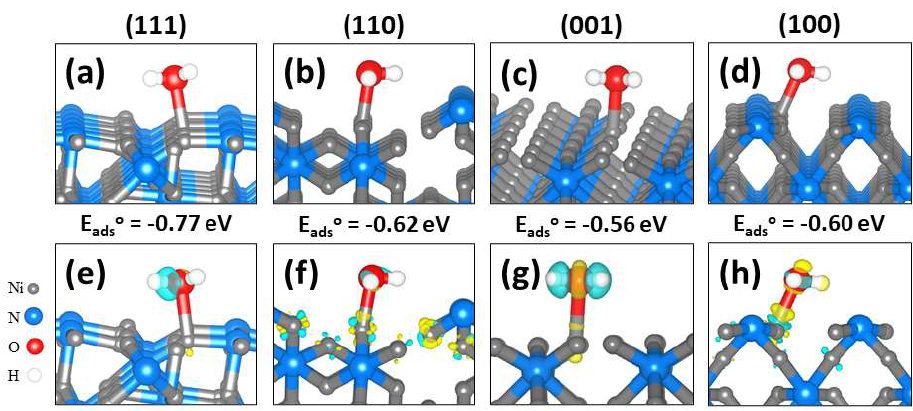
Figure 3. Lowest energy molecular water adsorption geometry on Ni 3 N (111), (110), (001), and (100) surfaces ( a – d ), with corresponding ZPE-corrected adsorption energies ( 𝐸 (cid:3028)(cid:3031)(cid:3046)(cid:3042) ). Each image is displayed with isosurface below ( e – h ), where accumulation is in cyan, and depletion in yellow. The depletion/accumulation levels were ± 0.0224 eV/Å 3 , as implemented in VESTA.